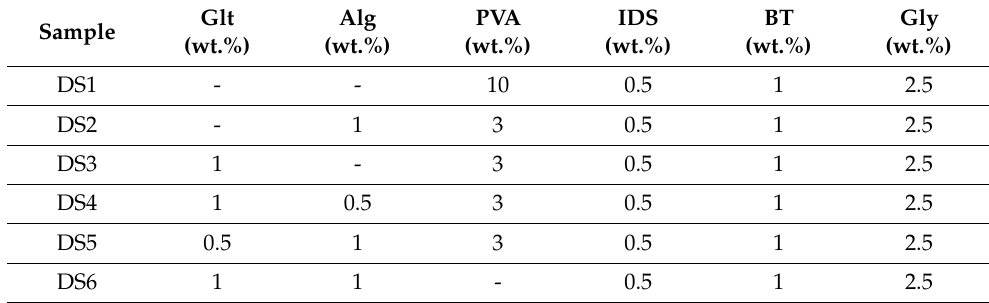
Table 1. Composition of decontamination